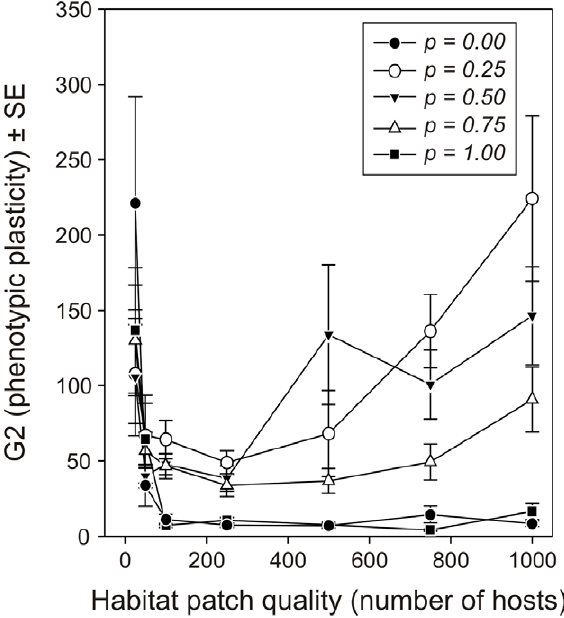
Figure 5. Effect of habitat patch quality and the probability for a parasitoid female to emerge on a host-containing habitat patch on the optimized values of the parameter G2. Average ( 6 SE) optimized values of G2 defining the range of phenotypic plasticity (see Figure 1) for parasitoid females foraging for hosts in environments with different habitat patch qualities and having different